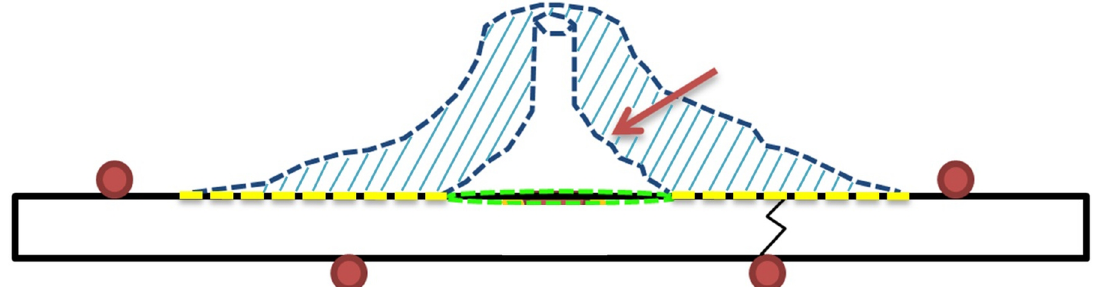
Figure 13. Scheme of the salt deposit formed on all the DETed specimens tested at 110 ºC for 500 h. The SCCs were nucleated under the salt deposit, approximately 22 mm away from the center of the dripping region, by crevice corrosion 41